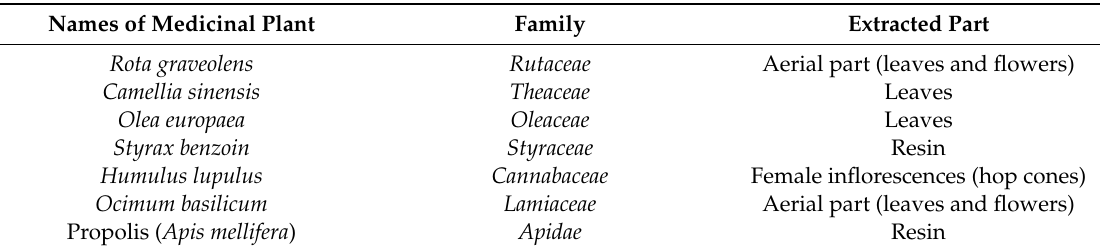
Table 4. Names of the medicinal plants, their families, and extracted parts used in this